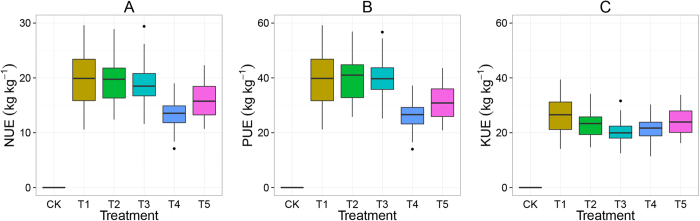
Effects of fertilization and soil conservation treatments on nitrogen use efficiency (A), phosphorus use efficiency (B) and potassium use efficiency (C) in wheat, as function of fertilization treatments during the period 1982–2012. The treatments are noted as: no fertilization (CK), mineral NPK (T1), NPK + low rate of straw (T2), NPK + high rate of straw (T3), NPK + pig manure (T4) and NPK + cattle manure (T5). Boxes show 25th and 75th percentiles (i.e. Q1 and Q3). Lines in the boxes show the median values. Please note that the values for CK were not zero but not applicable because there were no NPK input in CK.